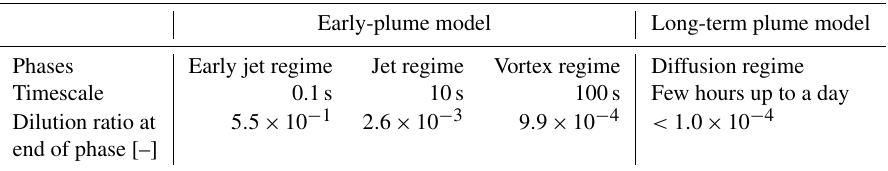
Table 1. Plume timescales and dilution ratios (Kärcher, 1995). Dilution ratios are the ratio of the initial plume air mass to the air mass at the target time.